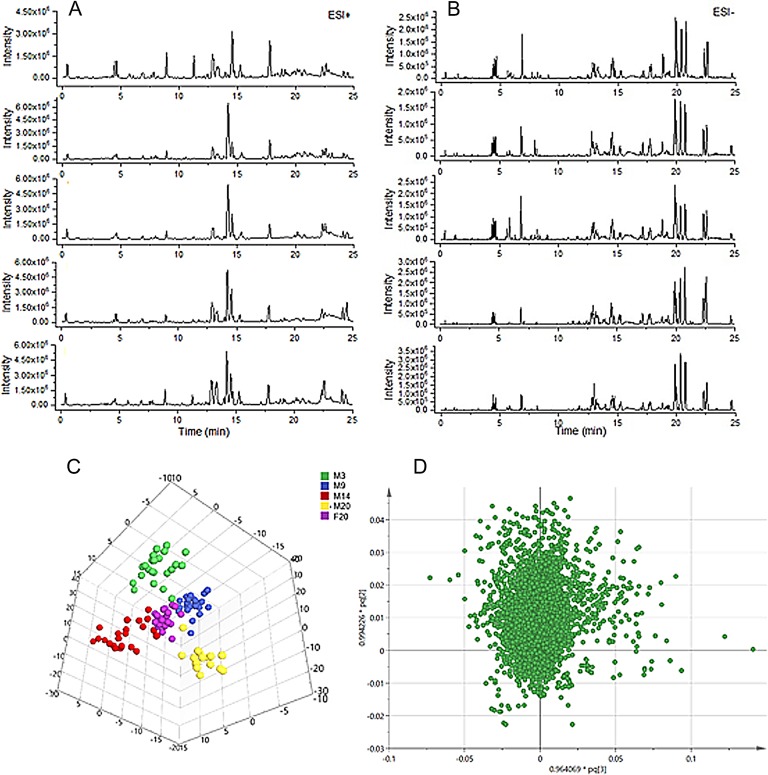
Profiling and multivariate statistical analysis. (A) Base-peak intensity chromatograms of different groups in positive ion mode obtained from UPLC-TOF/MS analysis. (B) Base-peak intensity chromatograms of different groups in negative ion mode obtained from UPLC-TOF/MS analysis. (C) Score plot of OPLS-DA of different groups (R2Y = 0.869, Q2 = 0.779). (D) Loading plot of OPLS-DA in positive ion mode from different groups.